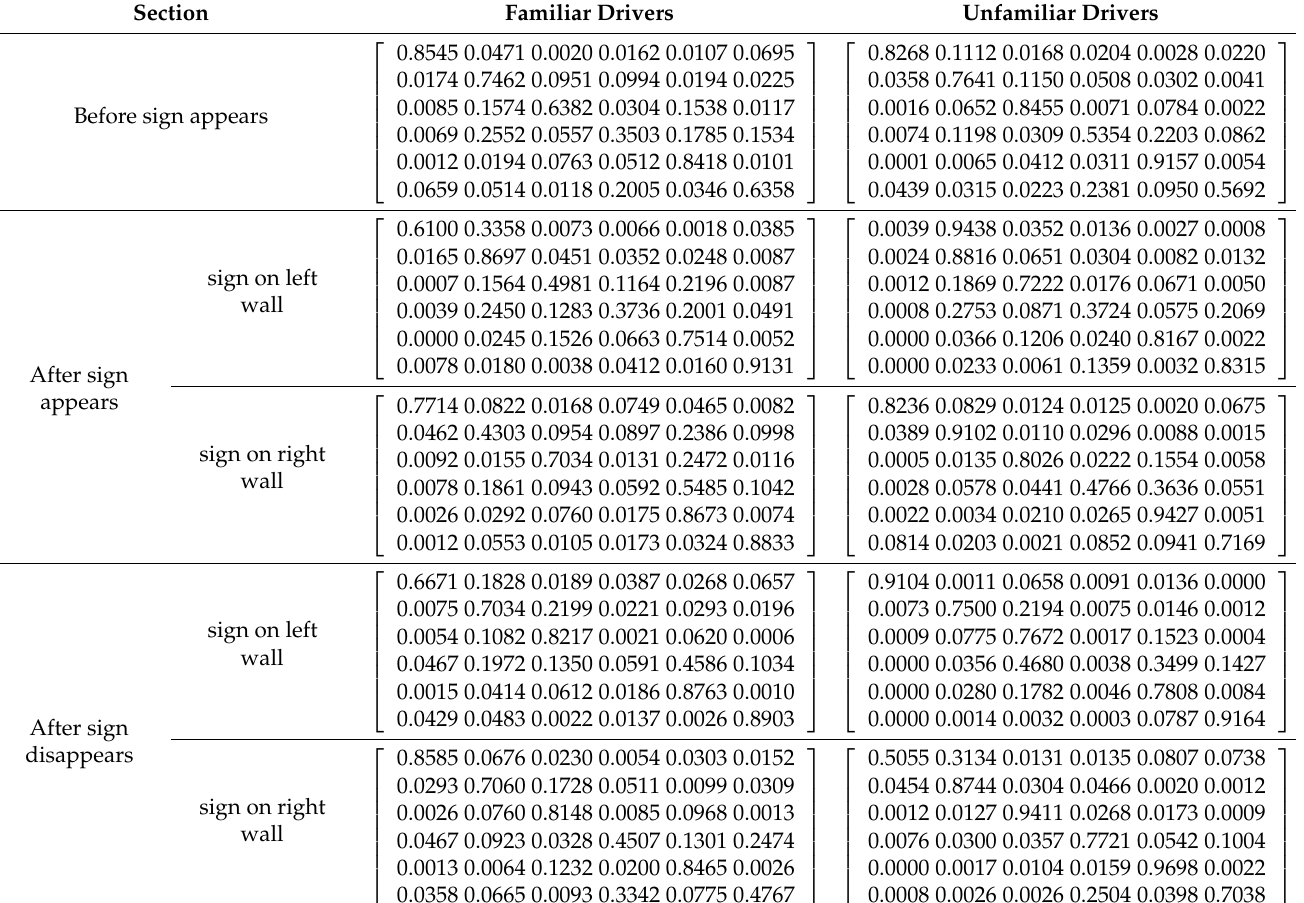
Table 3. Two-step gaze transition probability matrix in a